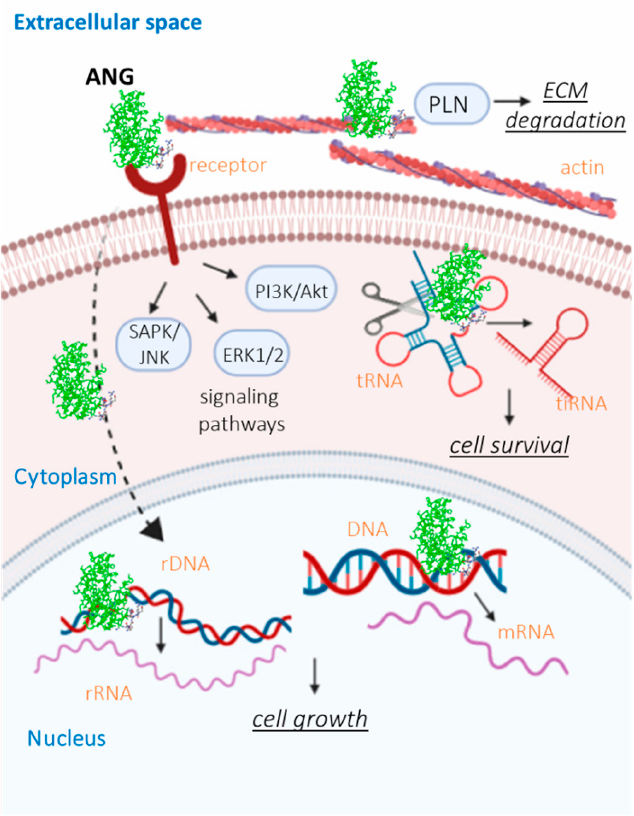
Figure 4. Mechanism of action of ANG. Extracellular ANG, through interaction with an endothelial surface cell receptor, activates several signal transduction pathways, including ERK1/2, SAPK/JNK and PI3K/Akt, thus promoting cell growth and differentiation. Moreover, extracellular ANG under- goes receptor-mediated endocytosis and accumulates in the cytoplasm, under stress conditions or in the nucleus, under growth conditions. Nuclear ANG stimulates both rRNA and mRNA transcription, allowing for cellular growth. In addition, ANG interacts with cell surface actin, leading to ECM and basement membrane degradation, thereby promoting cell migration and